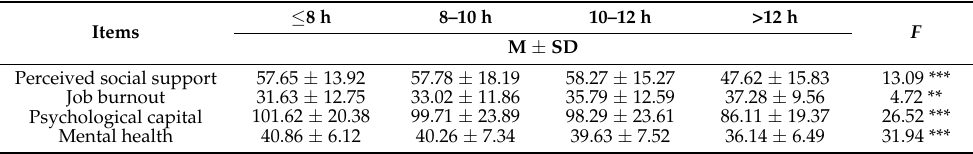
Table 13. Variance analysis on various variables with different daily working hours.